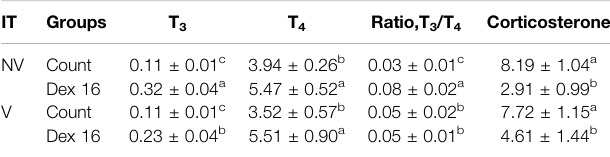
TABLE 1| Hormone levels (ng/ml) at day 18ofincubation according toincubation treatments (IT) and dexamethasone administration at day 16 (Dex 16) ( n = 24) of incubation or control eggs (Cont) ( n =